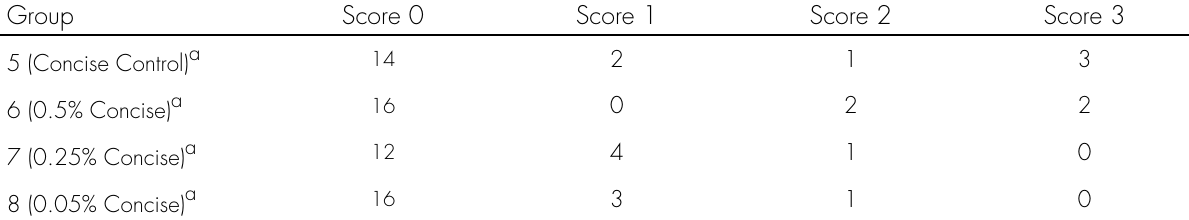
a Similar letters indicate no statistically significant differences between groups ( p > 0.05). Table IV. ARI scores for groups 5, 6, 7 and 8 (Concise).